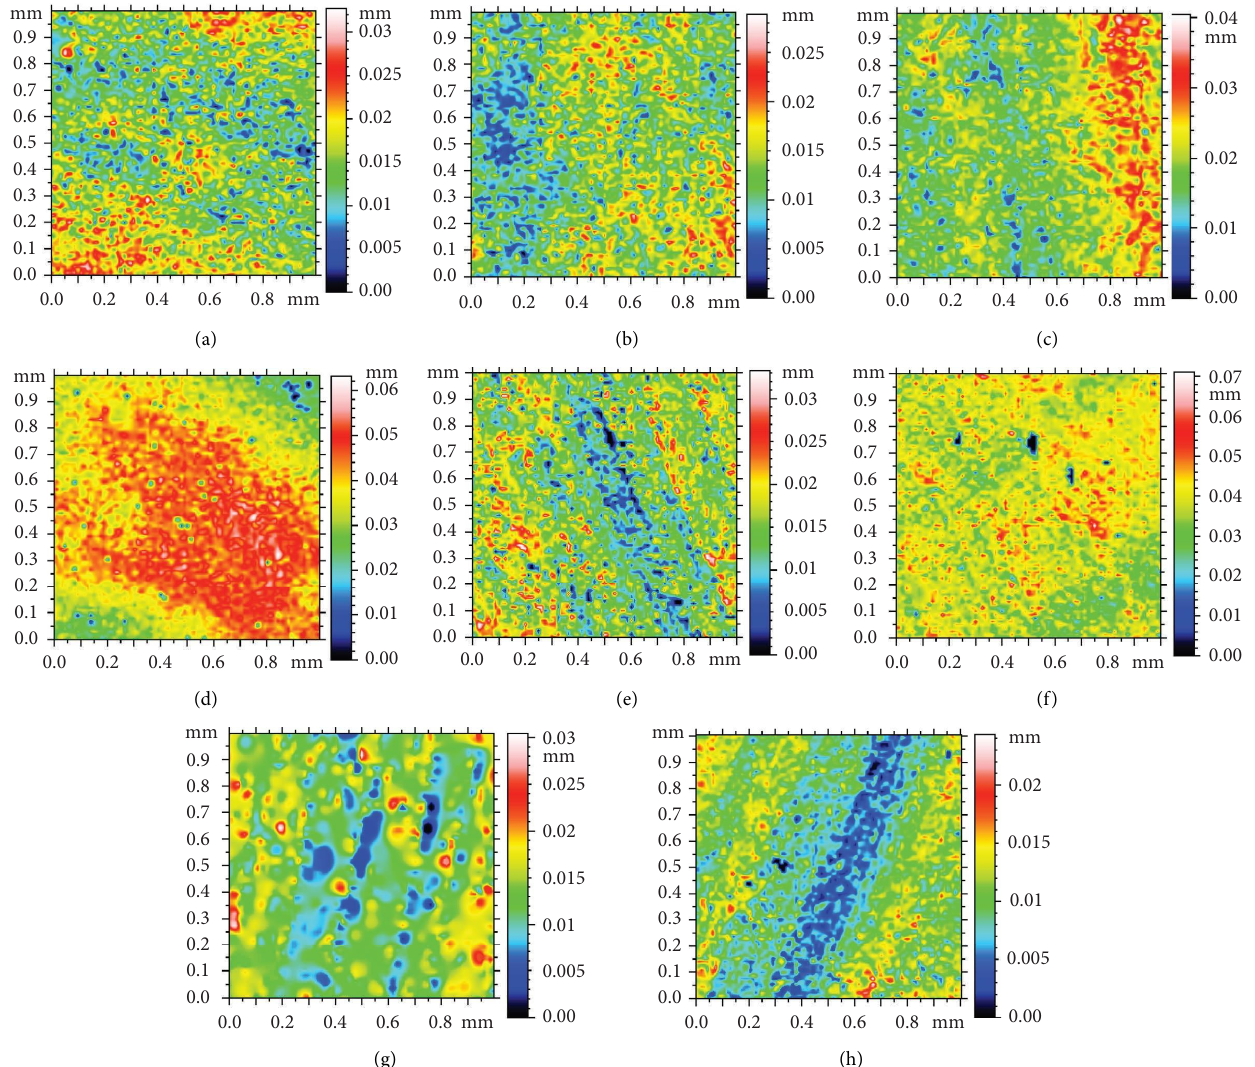
Figure 6: 2D surface topographies of wear track of glass ball at 400rpm/min under 5N (a), 8N (b), 10 N (c), 12 N (d); at 300 rpm/min (e), 400rpm/min (f), 500 rpm/min (g), and 600 rpm/min (h) under 9.8